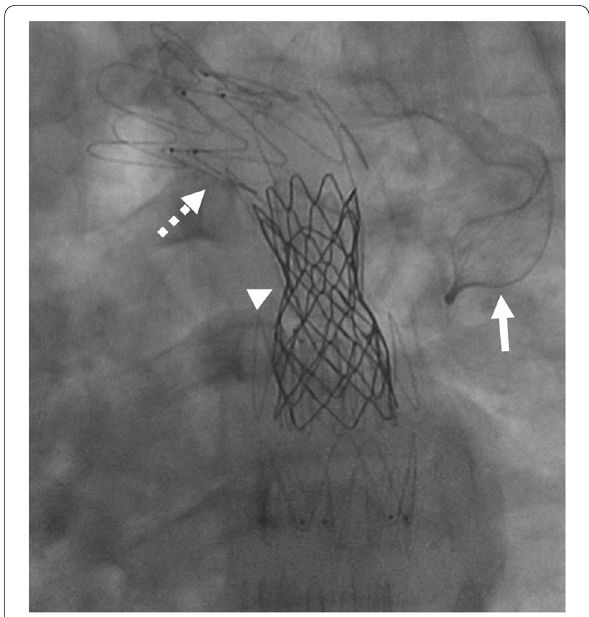
Fig. 5 Fluoroscopy after procedure. In order of embedding: Arrow: Occlutech device, dashed arrow: ZENITH stent (for exclusion of tube graft), arrow head: CP stent for coarctoplasty